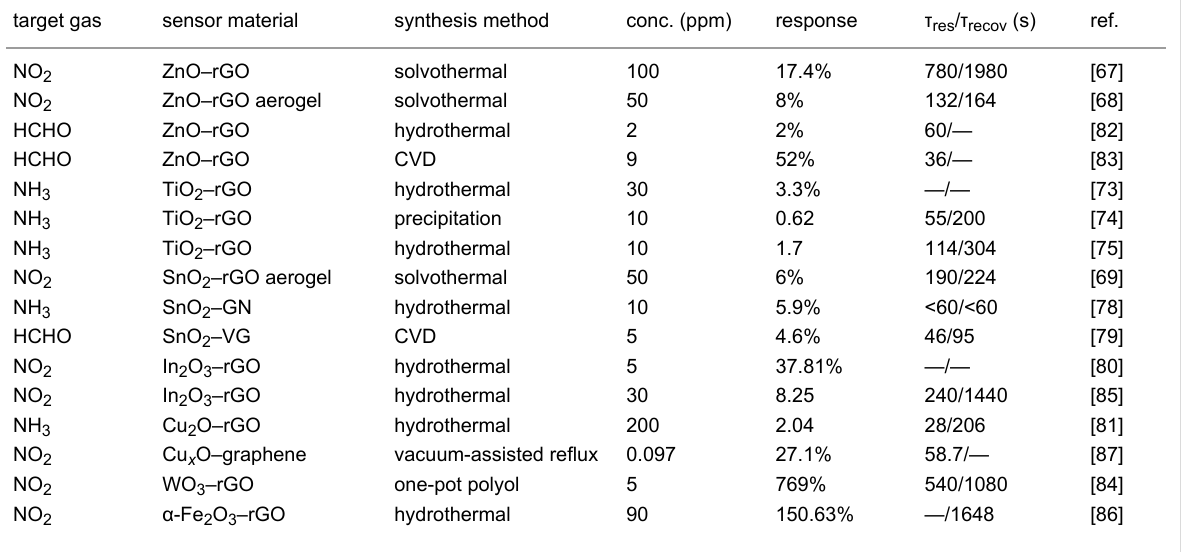
Table 3: Gas-sensing performance of graphene/metal-oxide sensors at room temperature. target